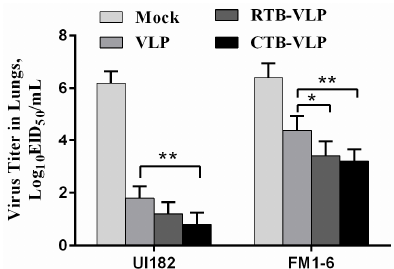
Figure 6. Intranasal immunization with cVLPs results in reduced lung viral loads following lethal challenge. Virus titers in the lungs of immunized mice were measured 4 days post-challenge with 10 MLD 50 of UI182 virus by titration in eggs. Viral titers are expressed as EID 50 /mL. Data are shown as the means ± SD (n = 3). * p < 0.05, ** p < 0.01.